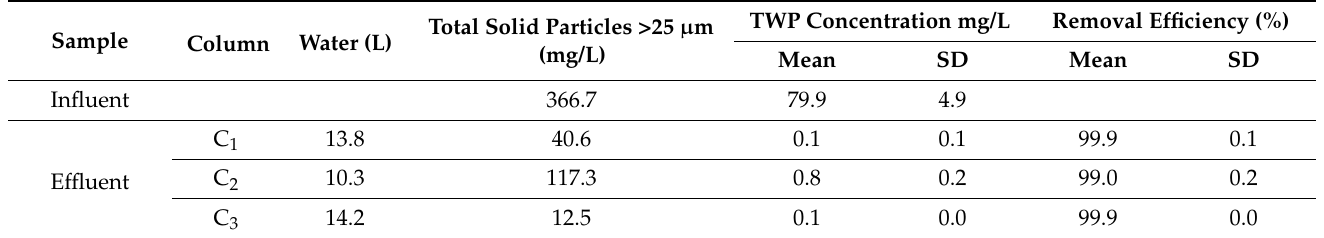
Table 2. Tire wear particles (TWP > 25 µ m) concentrations in the influent and effluent of bioretention columns (C 1 –C 3 ).